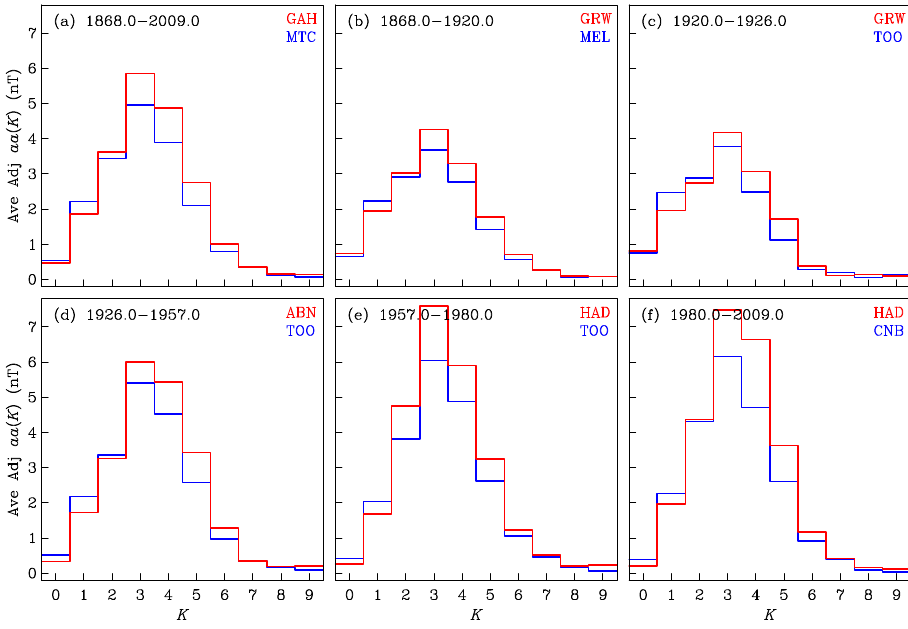
Fig. 3. The adjusted contribution w · r K · p ( K ) to long-term averages of the standard aa index, each for British (red) and Australian (blue) observatories: (a) 1868.0-2009.0 for observatory groups GAH and MTC, (b-f) the 5 subset durations of time defined by the continuous operation of a British-Australian pair of observatories. Compare with Fig. 1. rather large discontinuity in the adjusted ratio aa MTC /aa GAH at 1957.0 corresponding to the opening of the HAD observa-